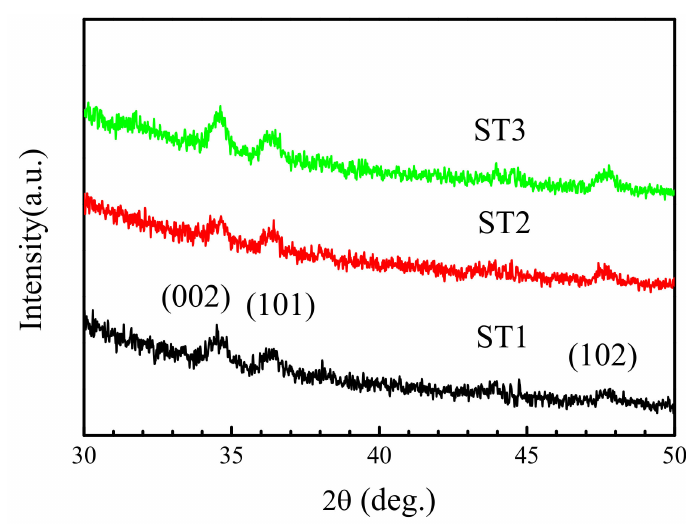
Figure 2. XRD patterns of samples ST1, ST2, and ST3.